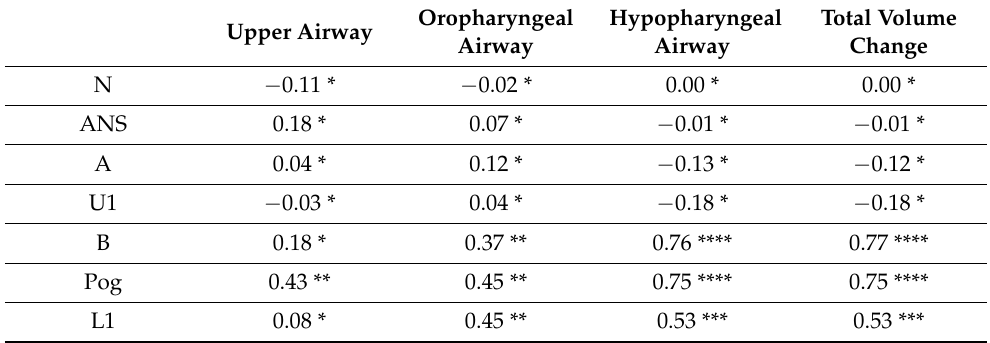
Table 7. Correlation between Changes in 3D Pharyngeal Airway Volume (mm 3 ) and Changes in 3D Distance of Seven